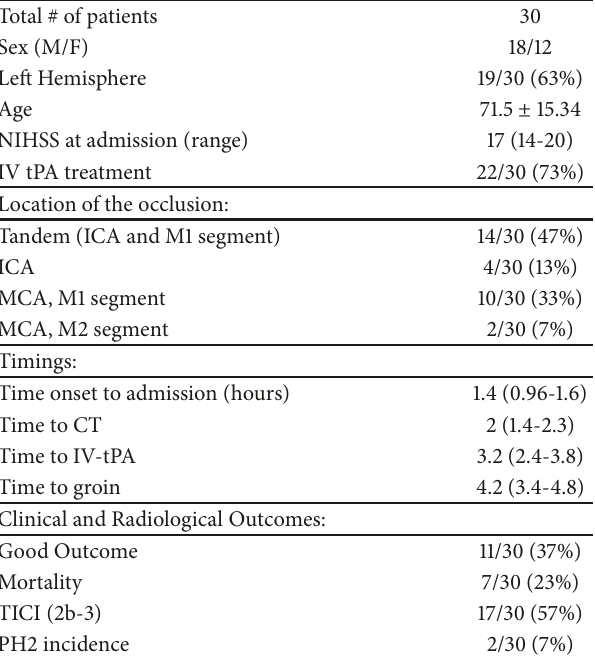
Table 3: Clinical and demographic variables, imaging characteris- tics, and